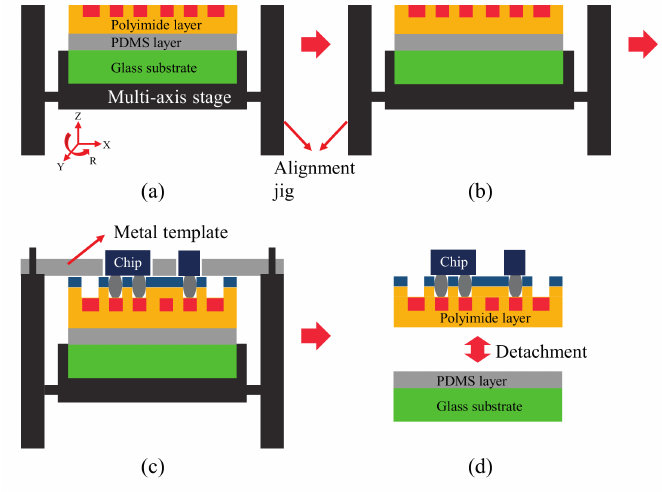
Figure 3. Schematic of the second part of the fabrication procedure: ( a ) alignment between the stencil mask and sensor device platform; ( b ) screen-printed solder paste on the interconnect layer; ( c ) passive alignment of chip components; ( d ) release of the flexible sensor